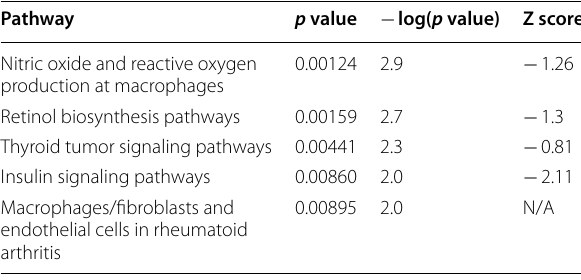
Table 4 Top five canonical pathways revealed by ingenuity pathway analysis